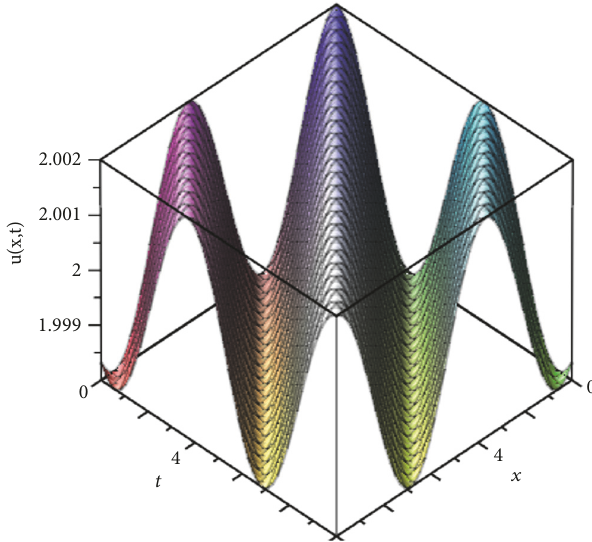
Figure 2: 3D plot of (46) with 𝑎 0 = 3.9 , 𝑎 1 = 1.7 , 𝑎 2 = 0.87 , 𝛾 = 1 , 𝛼 = 0.6 , 𝛽 = 1.